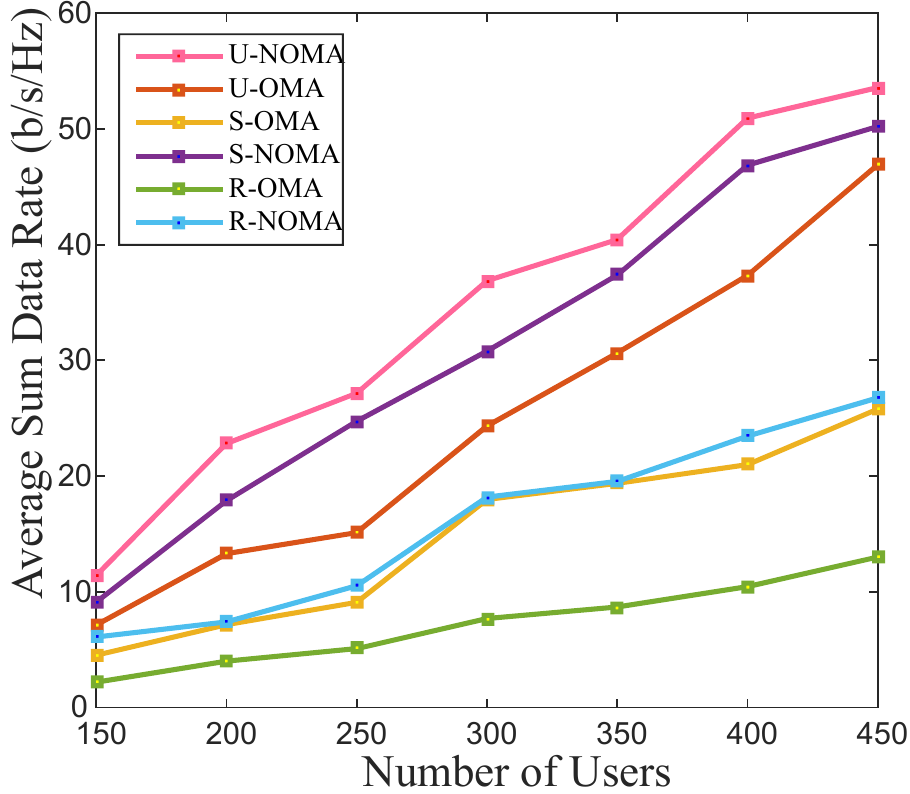
Figure 2. Average sum rate for a different number of total users in the cell.